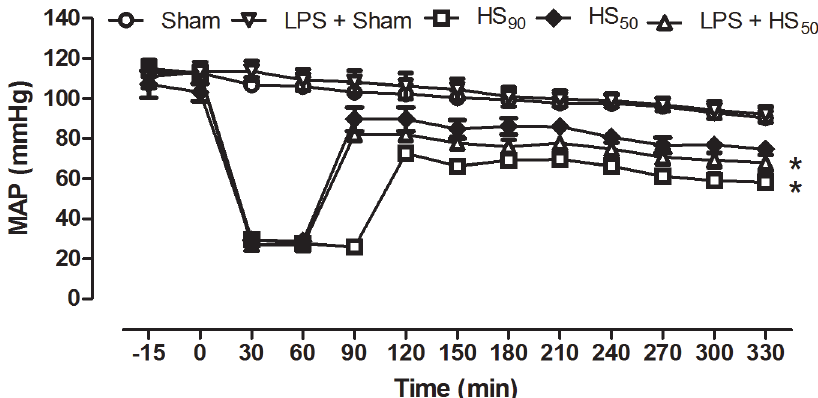
Fig 3. Effect of LPS preconditioning on mean arterial pressure (MAP) of rats. Rats were injected vehicle (PBS) or LPS (1 mg/kg) i.p. 24 h prior to HS 90 or HS 50 . The MAP was recorded during the whole experiment. Sham animals were used as control. Data are expressed as mean ± SEM of 8 – 10 animals. Statistical analysis was performed using two-way ANOVA followed by Bonferroni ’ s post hoc test. * p < 0.05 versus sham